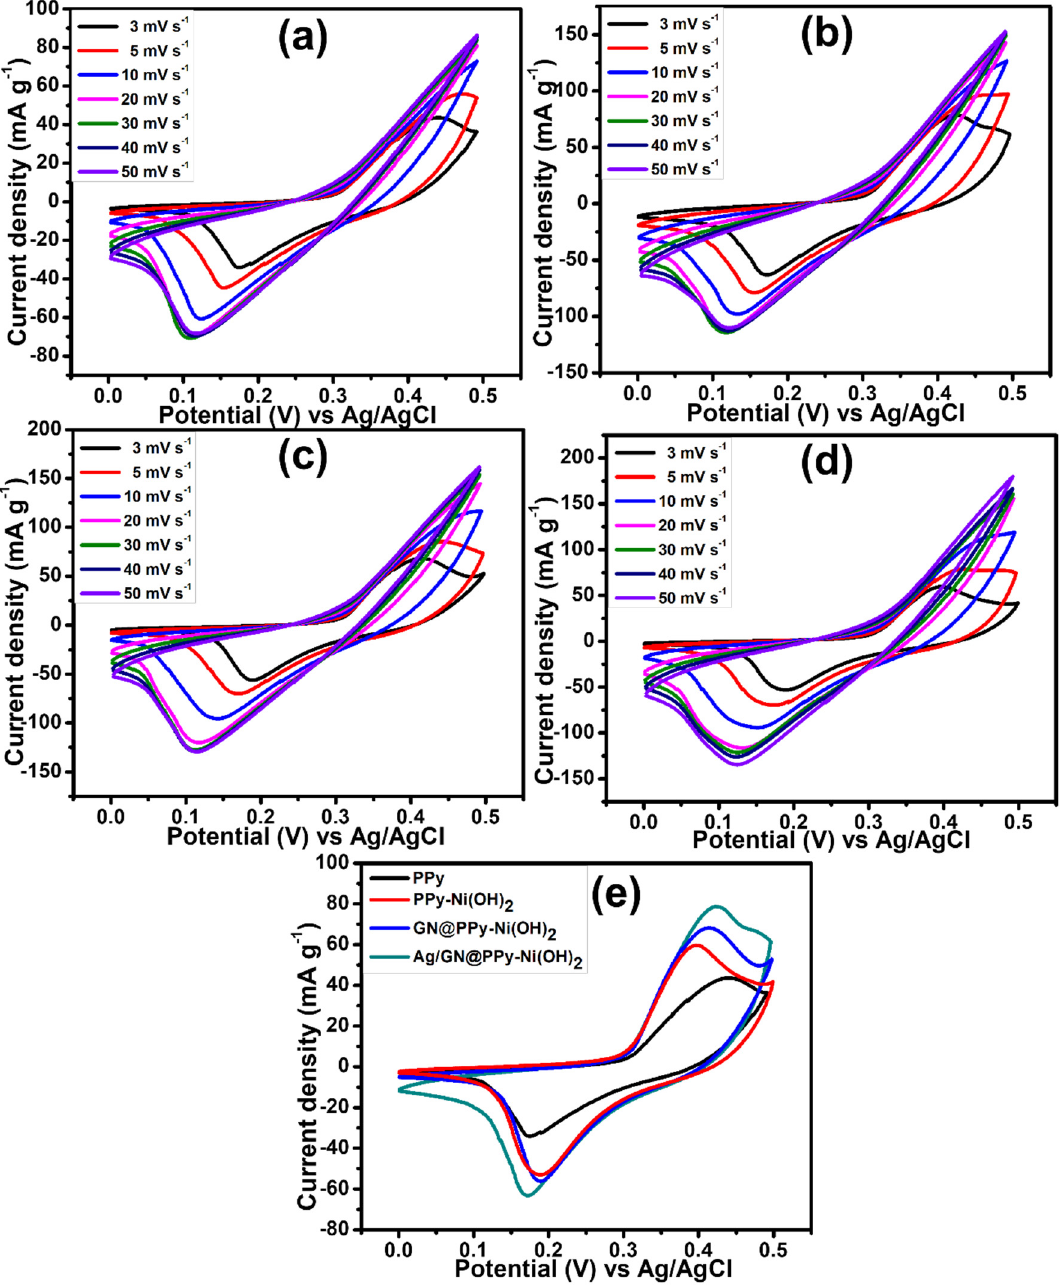
Figure 5. CV curves of ( a ) PPy, ( b ) PPy − Ni(OH) 2 , ( c ) GN@PPy − Ni(OH) 2 , ( d ) Ag/GN@PPy − Ni(OH) 2 , quaternary nanocomposites performed at different scan rates and ( e ) comparative CVs for PPy, PPy − Ni(OH) 2 , GN@PPy − Ni(OH) 2 , and Ag/GN@PPy − Ni(OH) 2 , at 3 mV s − 1 .